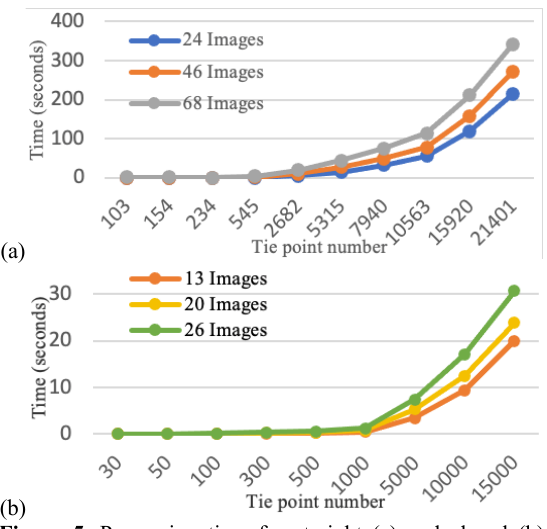
Figure 5. Processing time for straight (a) and closed (b)